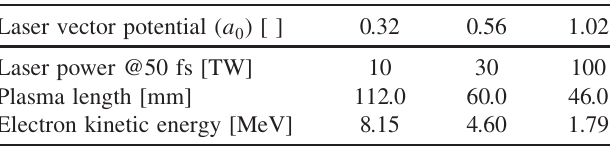
TABLE V. Optimized electron and plasma parameters for the various laser regimes when injecting electron bunches 300 fs in front of the laser pulse.